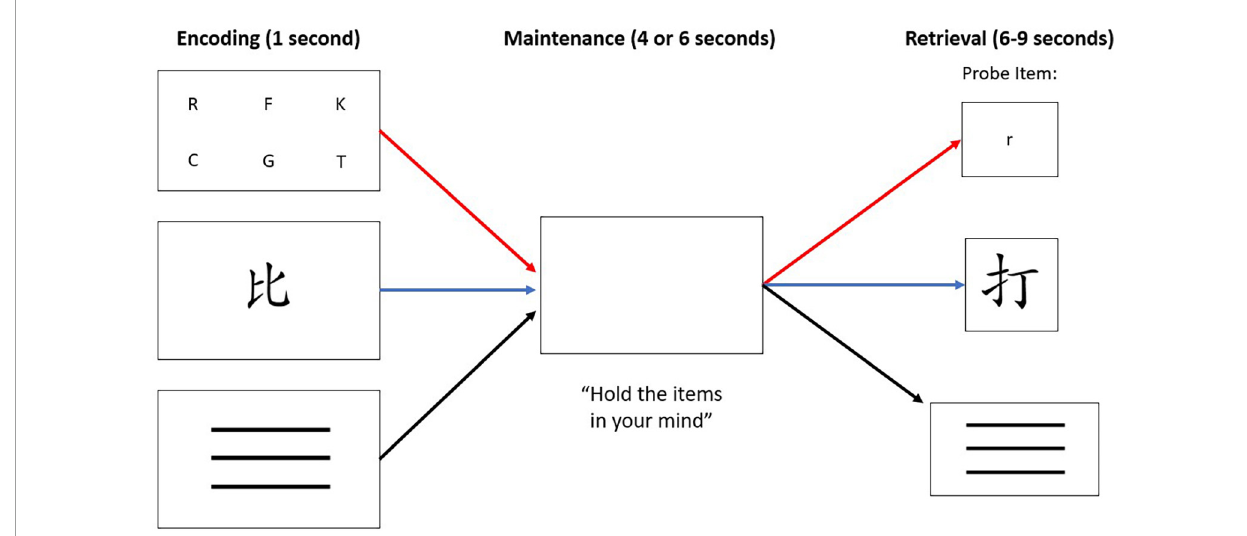
FIGURE1 The WM paradigm consisted of three conditions: verbal stimuli (letters), non-verbal stimuli (Chinese character), or “control condition” stimuli that was represented with three horizontal lines. Each trial, regardless of condition, consisted of three phases: encoding, maintenance, and retrieval. The red path depicts the verbal condition, the blue path depicts the non-verbal condition, and the black path depicts the control condition. Note that a match-to-target is depicted in the verbal condition. A non-match-to-target is depicted in the non-verbal condition. All control condition trials were a match-to-target, minimizing the WM load demand in that